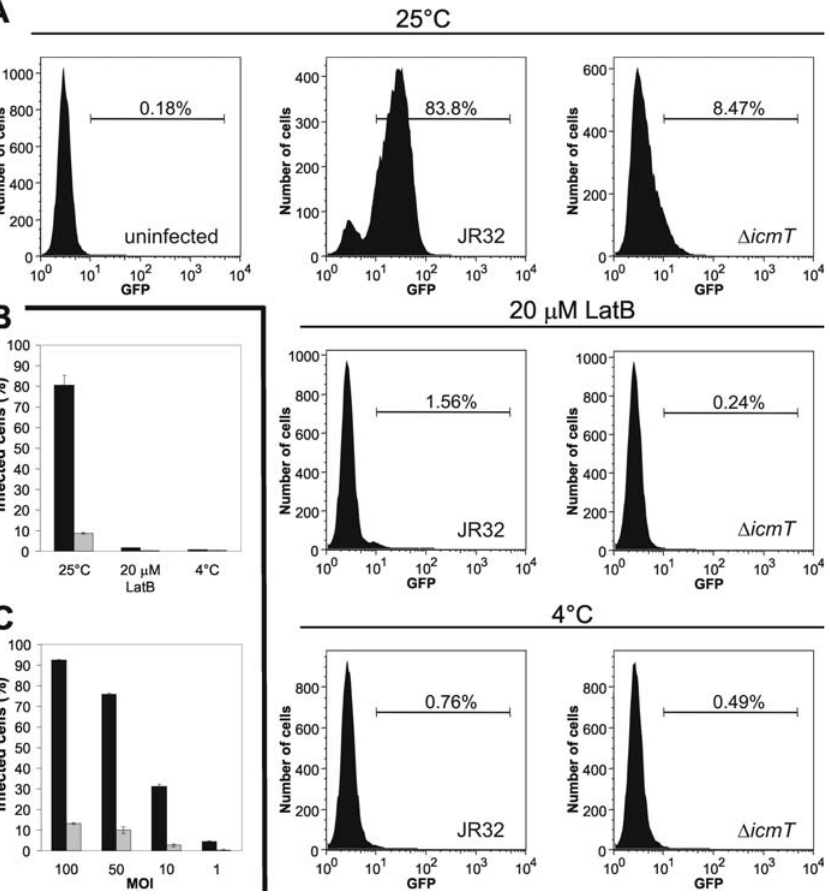
Figure 1. Phagocytosis of Wild-Type L. pneumophila or D icmT by Dictyostelium Phagocytosis of gfp -expressing wild-type L. pneumophila (black bars) or D icmT (grey bars) by Dictyostelium infected at (A and B) an MOI of 100 or (C) at the MOI indicated was analyzed by flow cytometry. The increase in GFP fluorescence (FL1, x -axis) indicates that, at MOIs ranging from 1–100, the number of wild-type L. pneumophila phagocytosed is about one order of magnitude higher than the number of D icmT. Phagocytosis is blocked by latrunculin B or incubation at 4 8 C. (B and C) The data shown are the means and standard deviations of duplicates and are representative of at least three independent experiments. DOI: